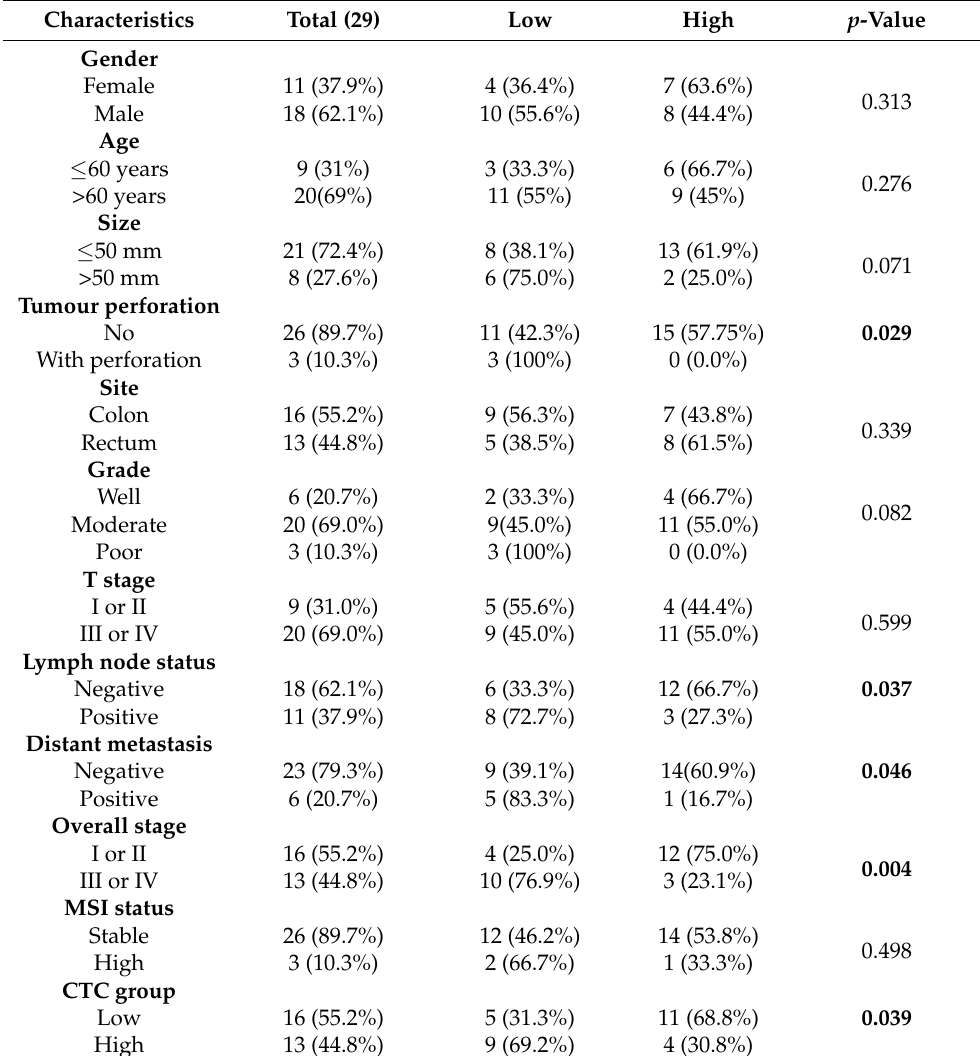
Table 2. The correlations of KRAS gene expression levels in CTCs with clinicopathological features in patients with